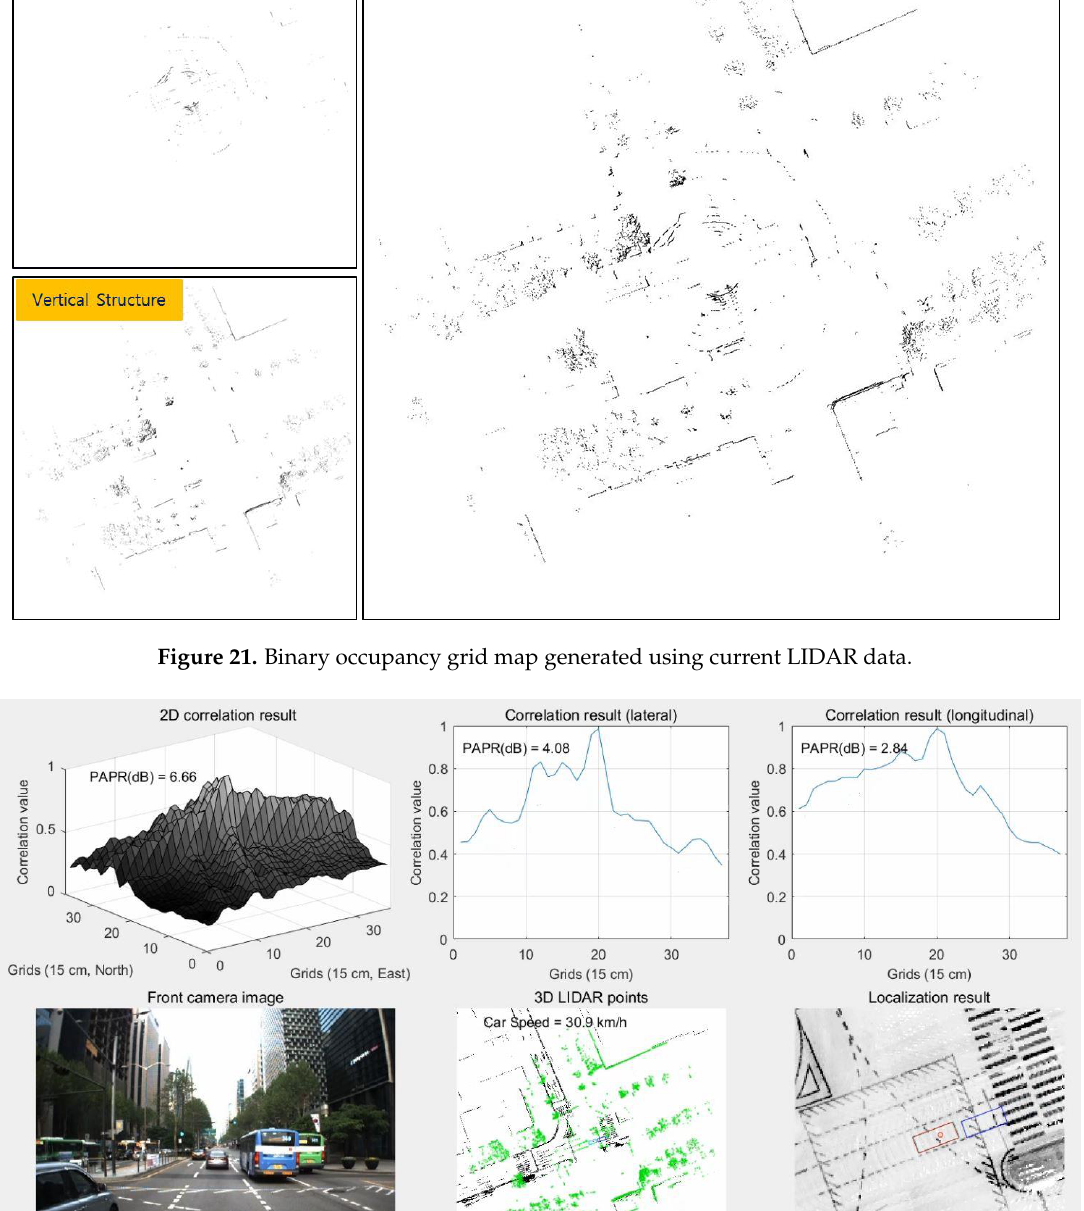
14 of 28 Figure 20. Result of converting Figure 19 into occupancy grid map.